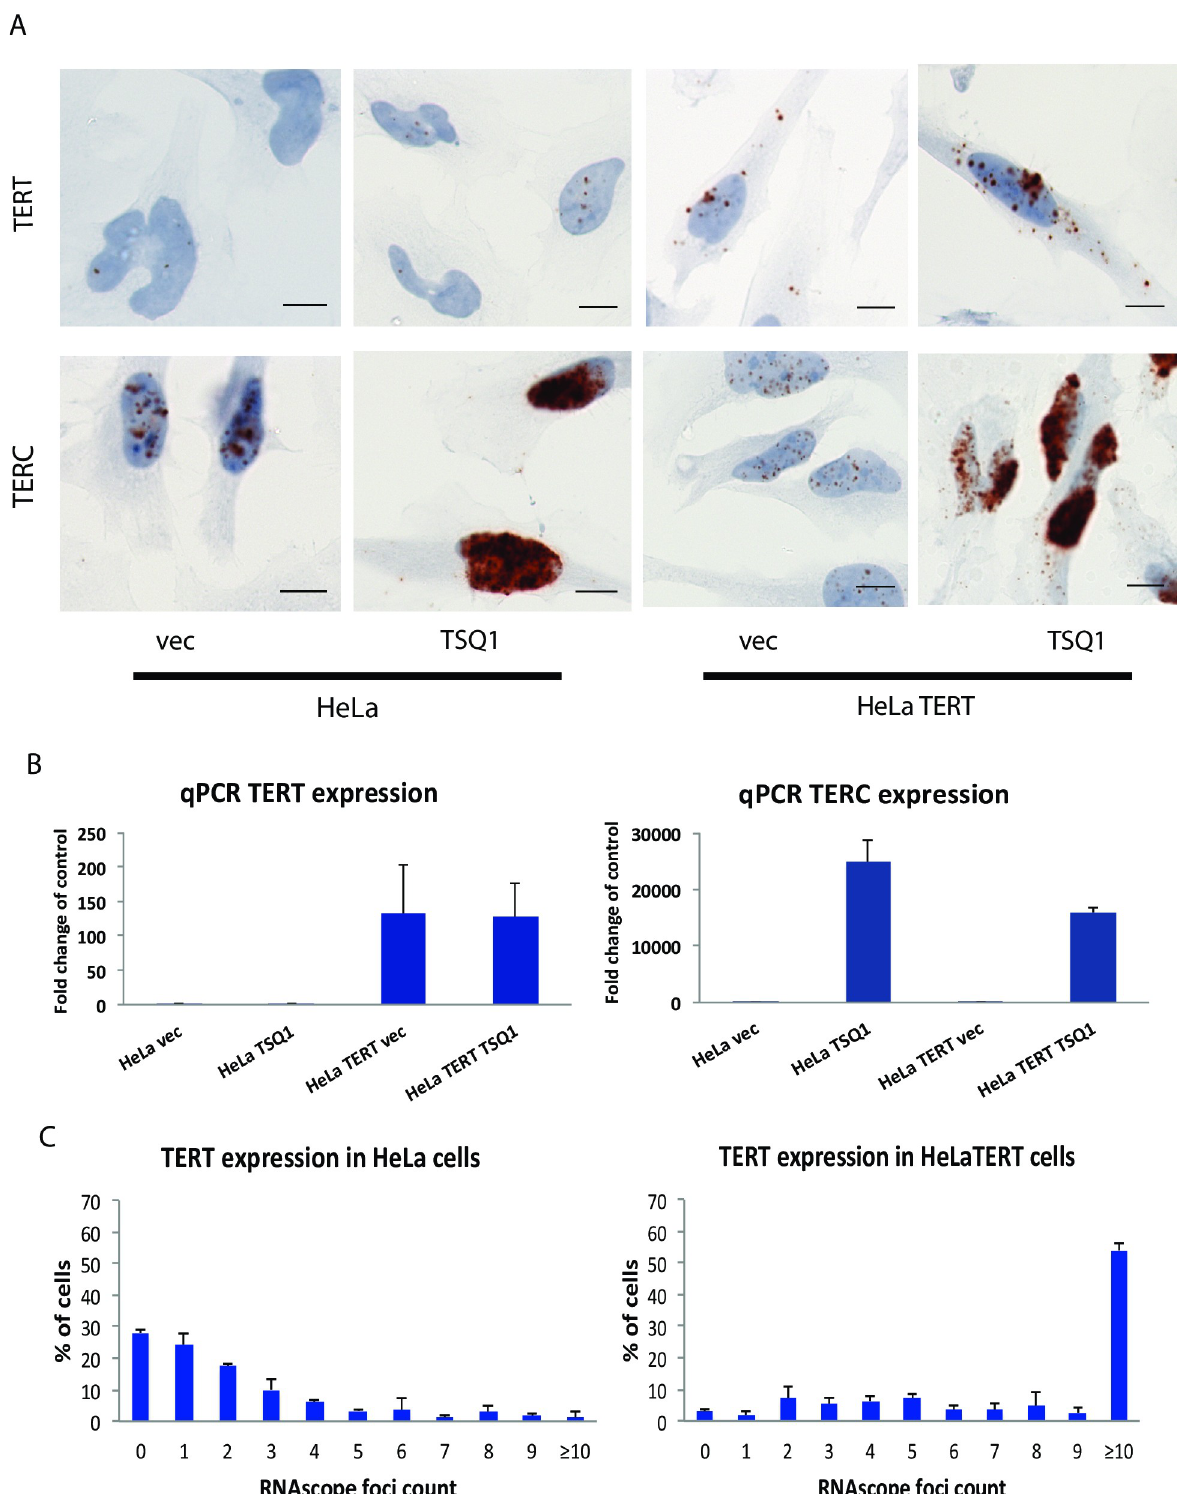
Fig 1. RNAscope detects TERC and TERT in heterogeneous cell populations. A. Representative images showing HeLa cells and HeLa cells overexpressing TERT (HeLa TERT), stained for TERT mRNA and TERC. Each of these cell types was infected with a lentiviral plasmid expressing the TSQ1 mutant TERC or a vector control (vec). Scale bars denote 10 μ M. B. qPCR to measure TERT and TERC expression in HeLa vec, HeLa